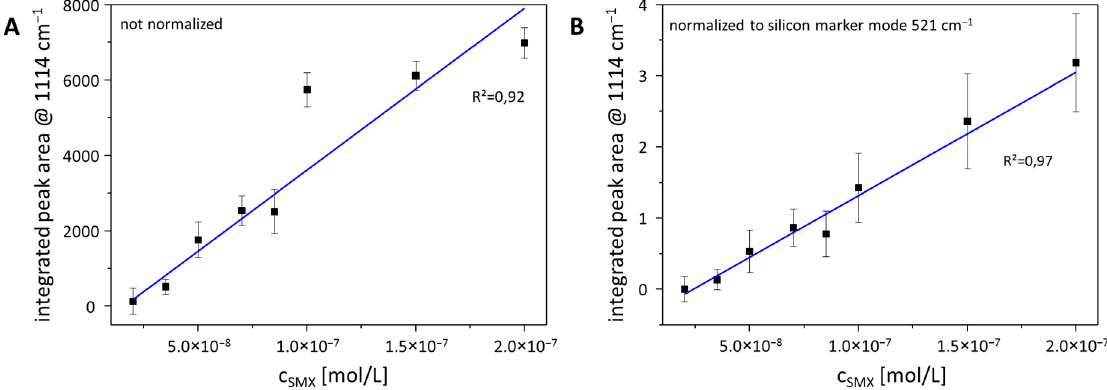
Figure 4. Concentration-dependent peak area as function of the SMX concentration ( A ) without normalization and ( B ) after normalization by using the peak area of the silicon marker mode at 521 cm − 1 as internal standard.